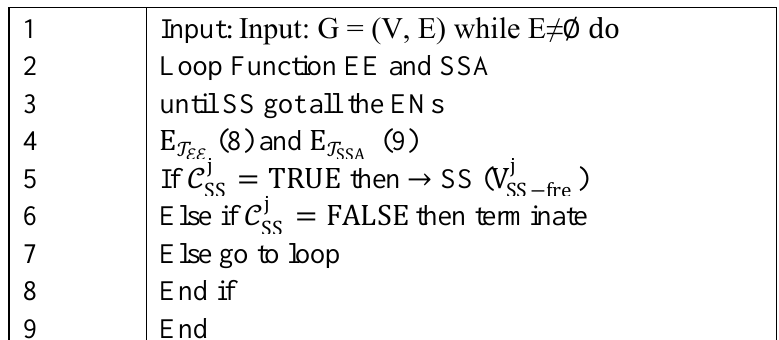
Table 3. SS self-RD